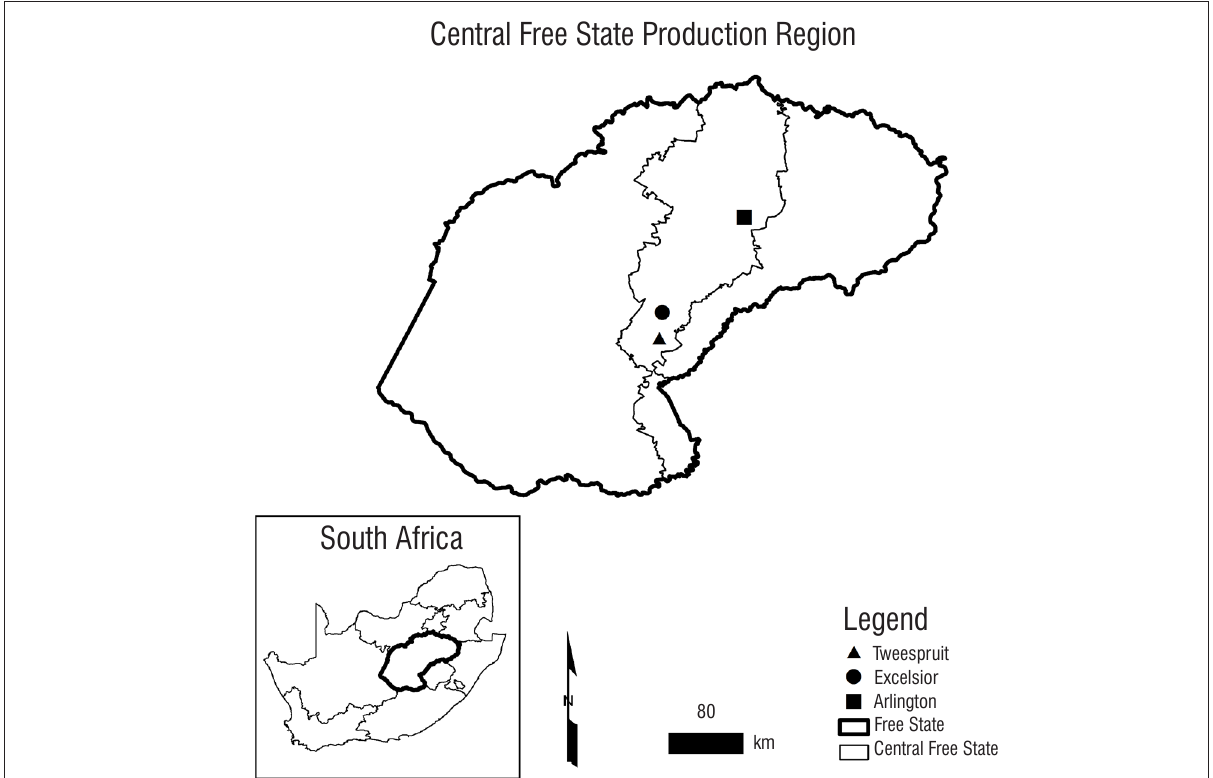
Figure 1: Map of the Central Free State wheat production region depicting the three study